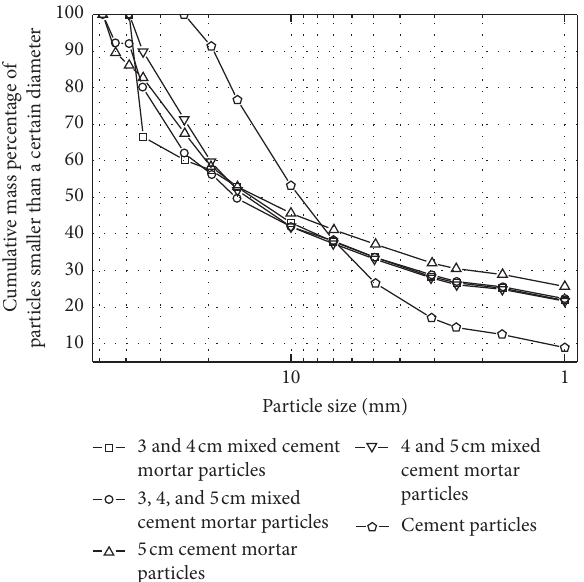
Figure 11: The size distribution for different particles under the same loading.